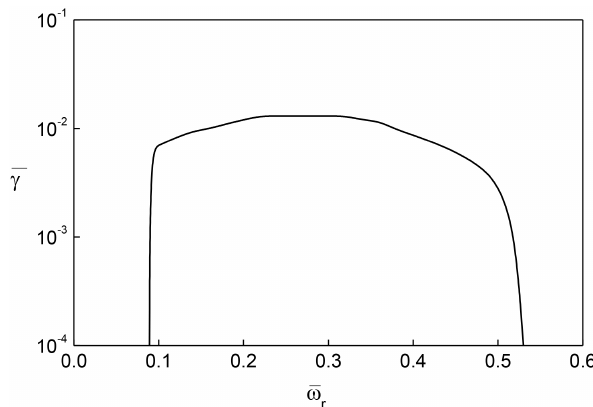
Figure 1. Normalized temporal growth rate γ ( = γ/(cid:127) e ) versus nor- malized real frequency ω r ( = ω r /(cid:127) e ) for whistler mode